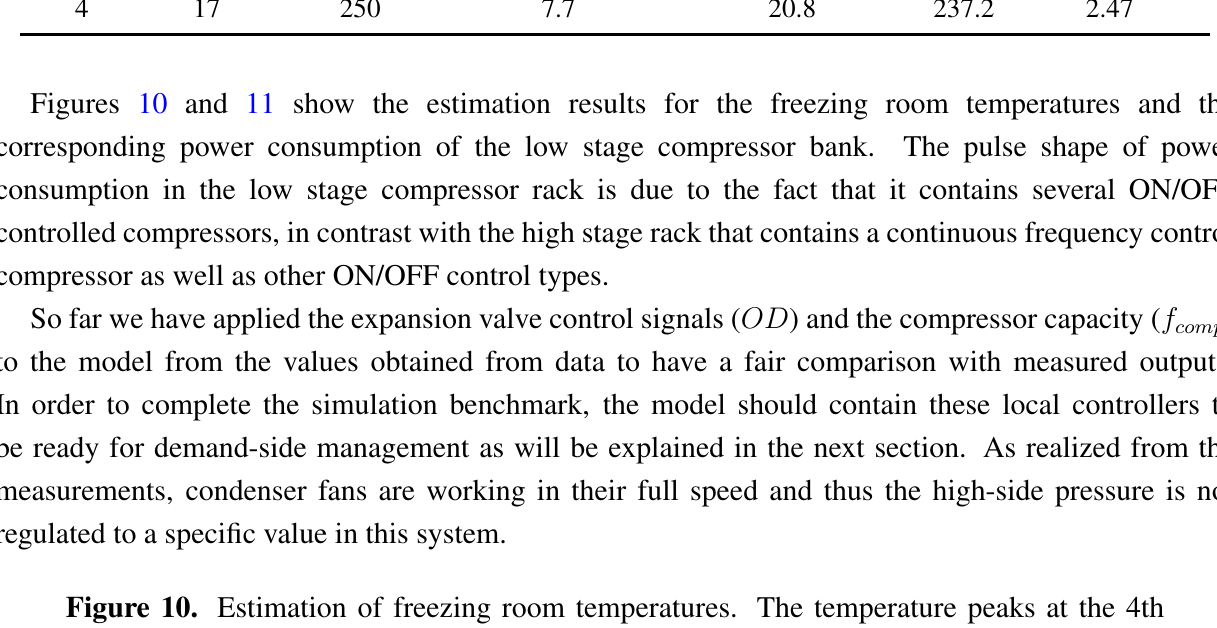
Figure 10. Estimation of freezing room temperatures. The temperature peaks at the 4th freezer may be caused by unmodeled disturbances like personnel activities. ( a ) Estimation using training data; ( b ) Estimation using validation